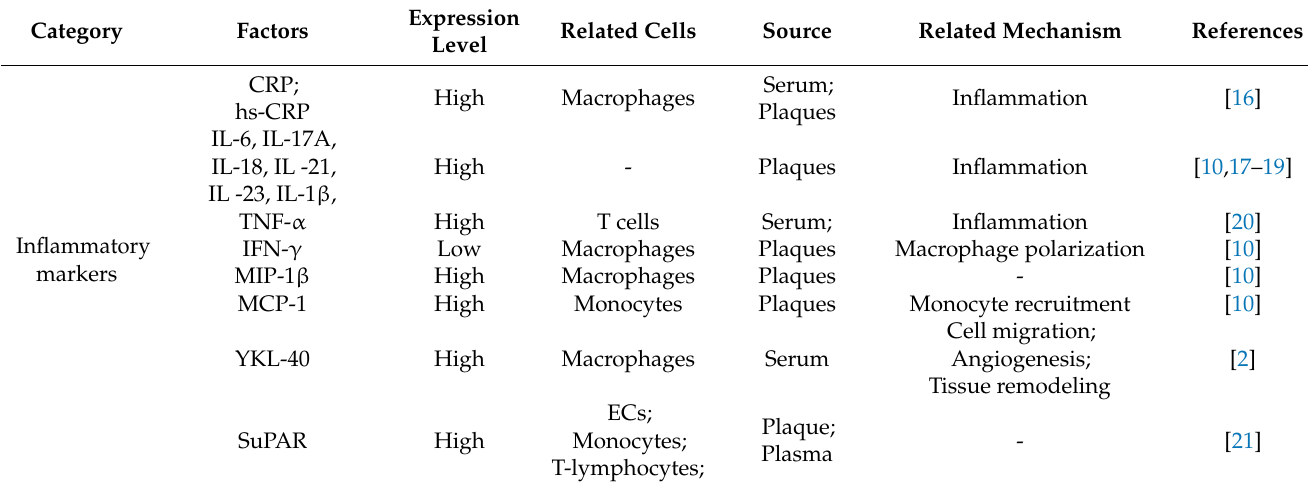
Table 1. Microscopic factors that potentially predict vulnerable